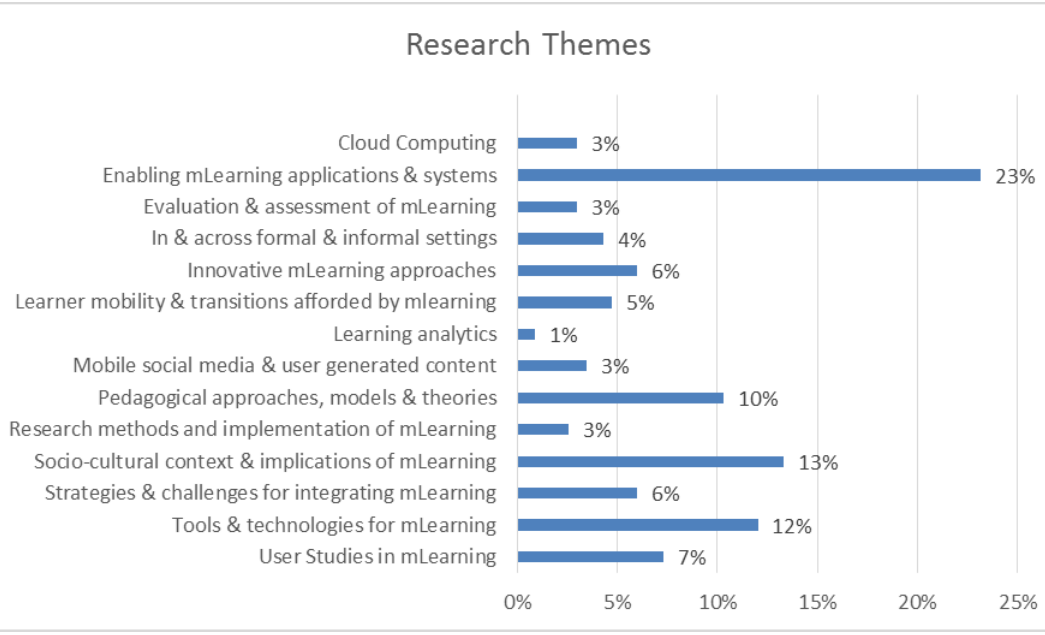
Figure 2. Distribution of studies by research